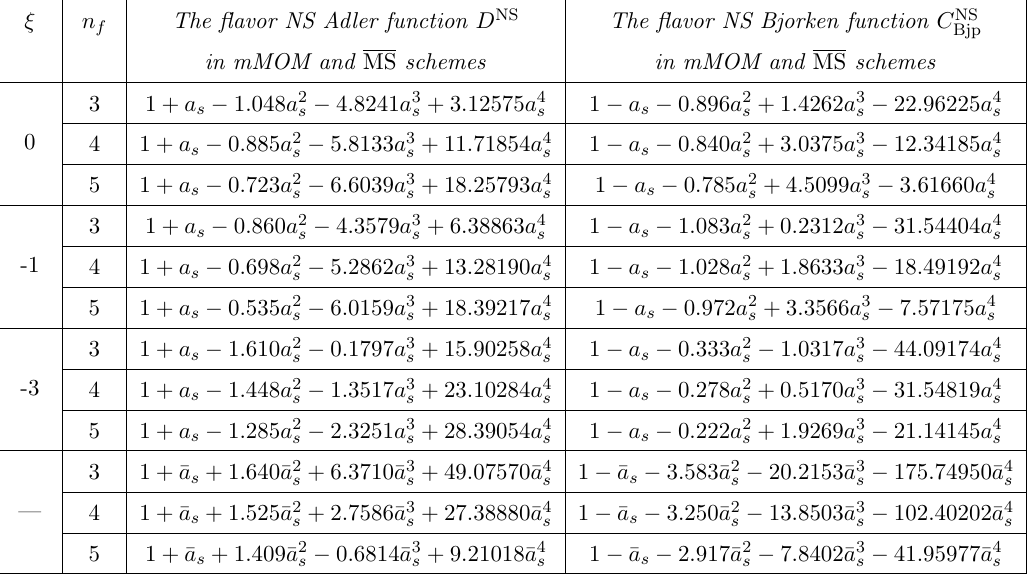
Table 1 . The comparison of the O ( a 4 in QCD with n f = 3 ; 4 ; 5 active (cid:13)avors in mMOM-scheme with (cid:24) = 0 ; (cid:0) 1 ; (cid:0) 3 and MS-scheme ((cid:22) a s corresponds to the calculation in the